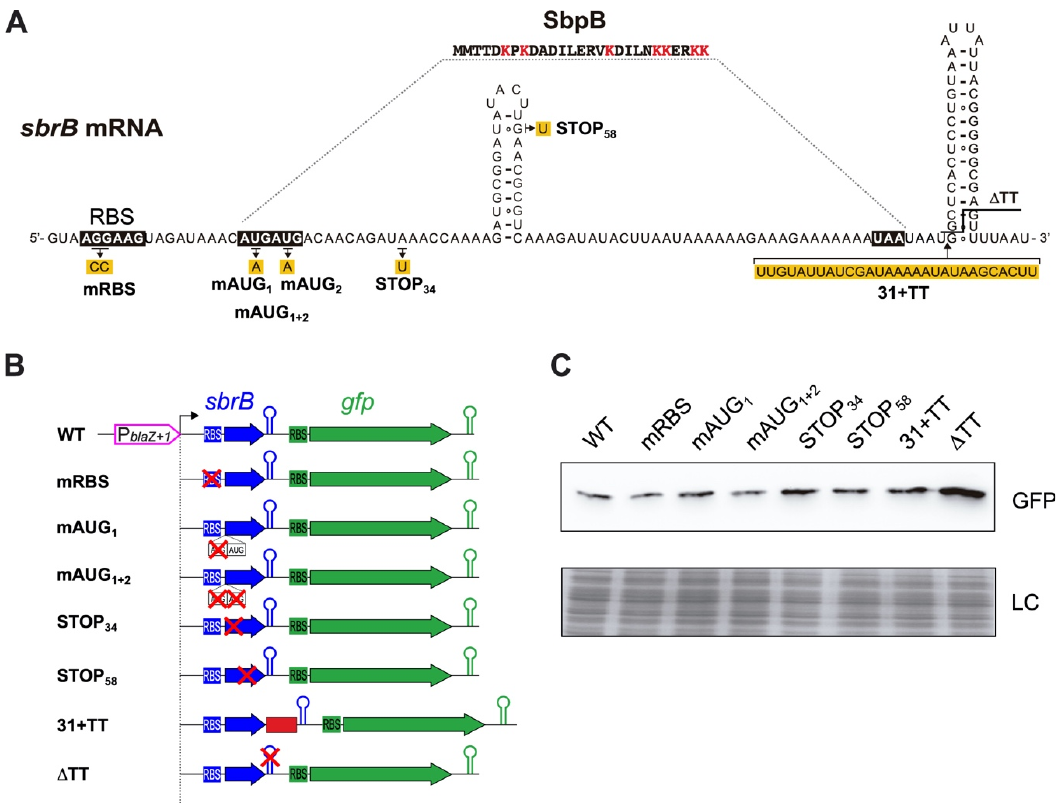
Figure 3. The TT sbrB read-through is not modulated by SbpB translation. ( A ) Schematic representation of the sbrB mRNA indicating the ribosome binding site (RBS), the putative start codons (AUG), the small protein SbpB sequence (lysines are colored in red) and the transcriptional terminator structure. The nucleotide modifications performed in the sbrB mRNA are highlighted in yellow. ( B ) Schematic representation of the different plasmids harboring translation and the transcriptional read-through reporters, respectively. WT and mutant mRNAs were expressed under the control of the P blaZ+ 1 promoter. ( C ) Western blot analyses showing the GFP levels produced from the different plasmids. Membranes were incubated with monoclonal anti-GFP and developed with peroxidase-conjugated goat anti-mouse antibodies and a bioluminescence kit. Coomassie gel portions are included as loading controls (LC).